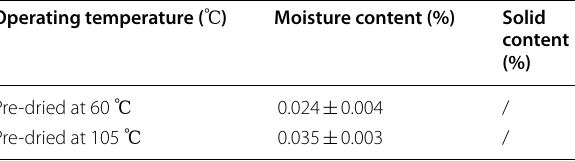
Table 4 Moisture and solid content of rubber seed oil